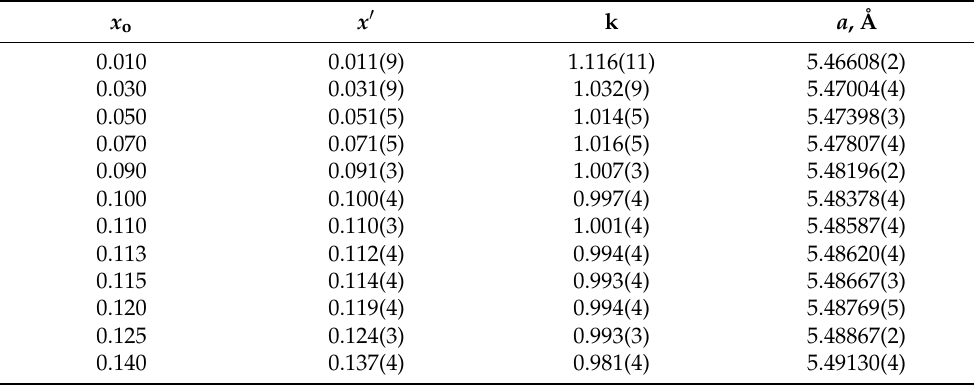
Table 3. The concentration of Y in a charge ( x o ), in the region of the seed cone ( x (cid:48) ), and the effective distribution coefficient (k) of Y in Ca 1 − x Y x F 2+ x